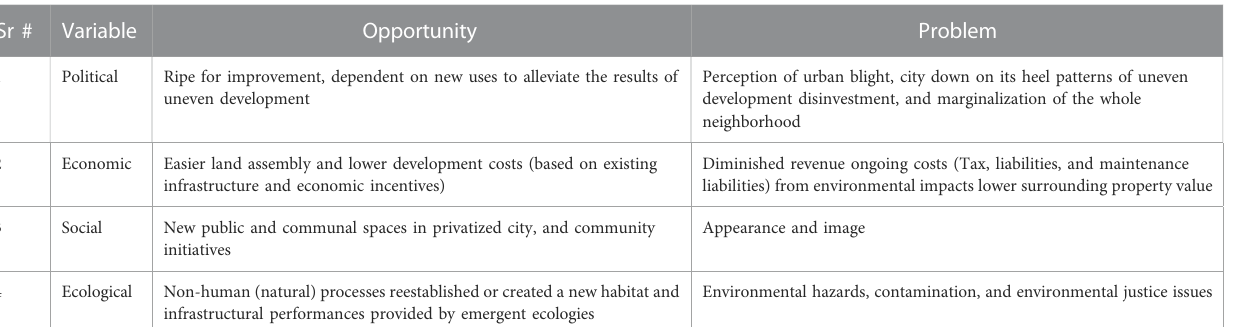
TABLE 2 Views of urban voids (Nemeth and Langhorst,